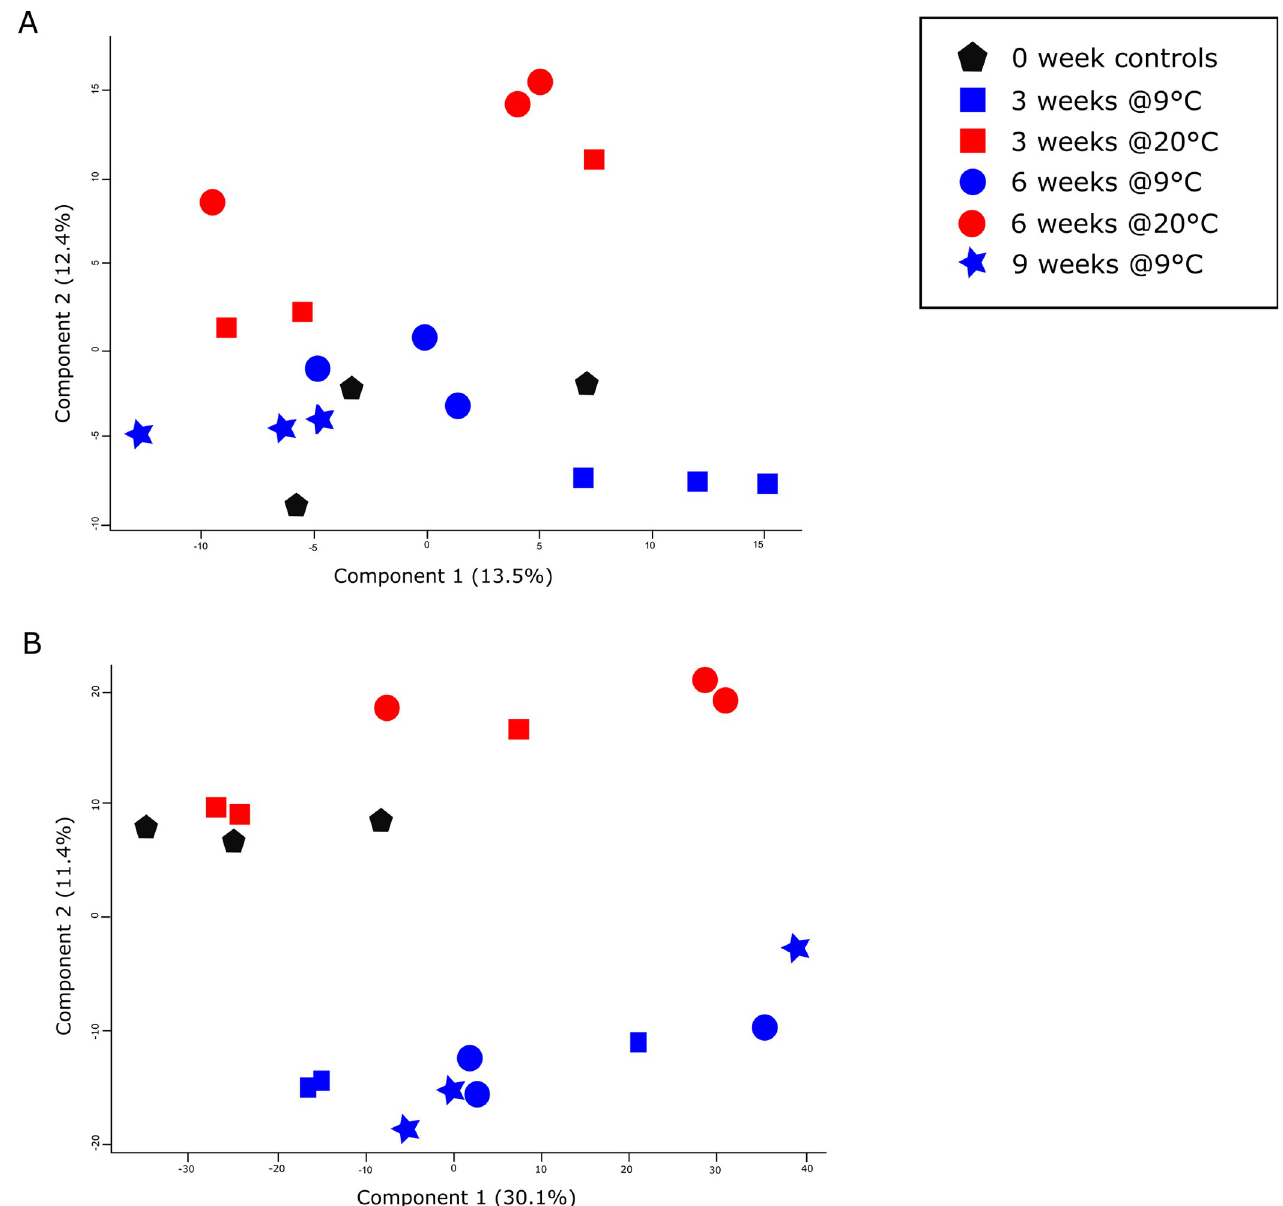
Fig 1. Principal Component Analysis (PCA) of the H . megidis (A) and S . carpocapsae (B) proteomes at time 0, or after storage at either 9˚C or 20˚C for up to 9 weeks. A clear distinction can be seen between IJs stored at 20˚C and